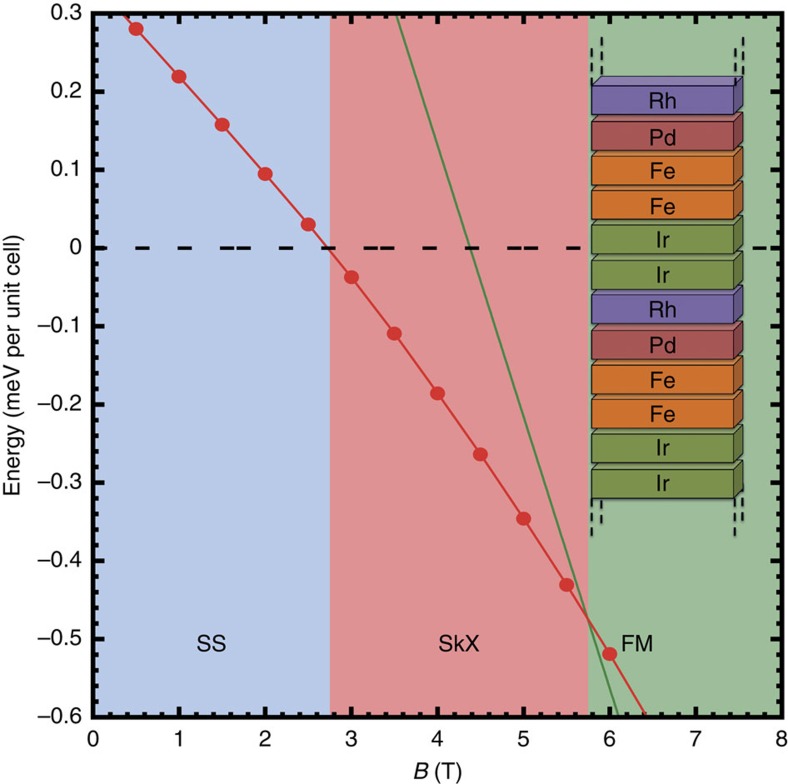
Low-temperature magnetic phase diagram of the multilayer Rh/Pd/2Fe/2Ir.The total energy of the FM state (green line) and of the skyrmion lattice (SkX, red line) is shown with respect to the spin spiral (SS) state (dashed black line). The regimes of the SS, SkX and FM phase are indicated by blue, red and green colour, respectively. The multilayer structure is shown in the inset.